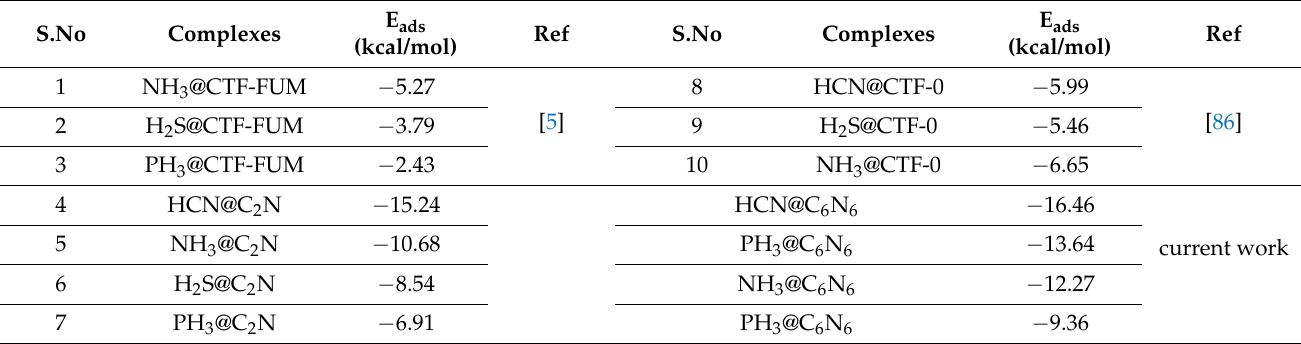
Table 4. Comparison of adsorption energy of H-containing industrial pollutants over C 6 N 6 with already reported values of different analytes over C 6 N 6 and other